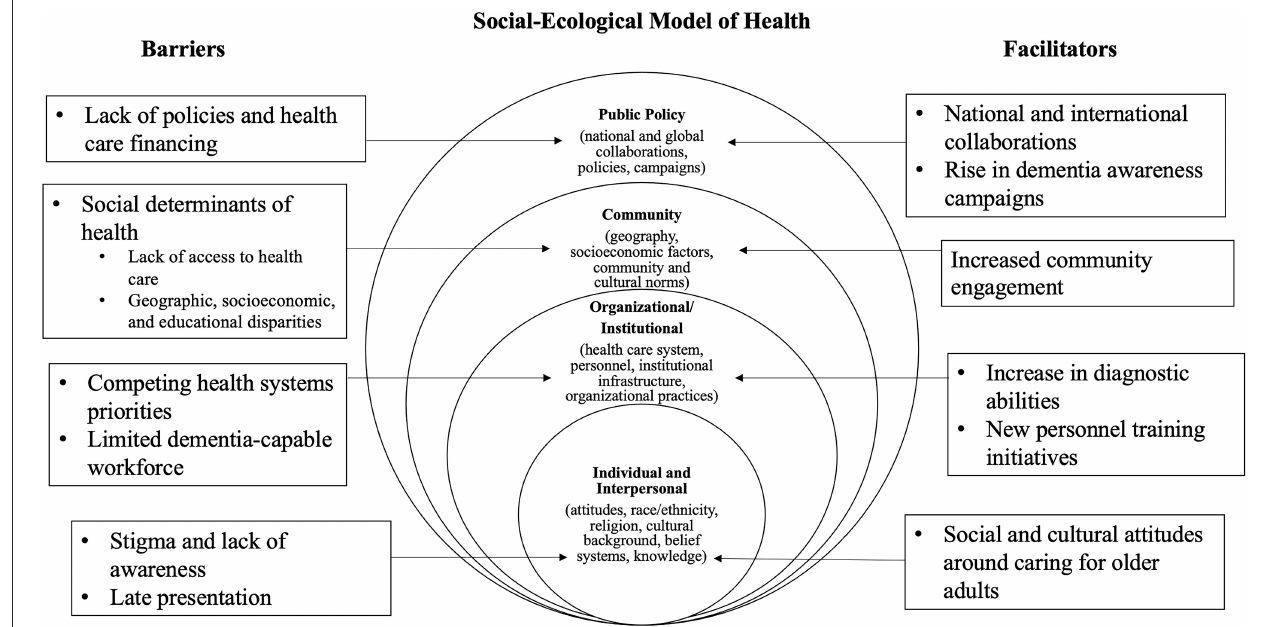
FIGURE 1 | Social ecological model of